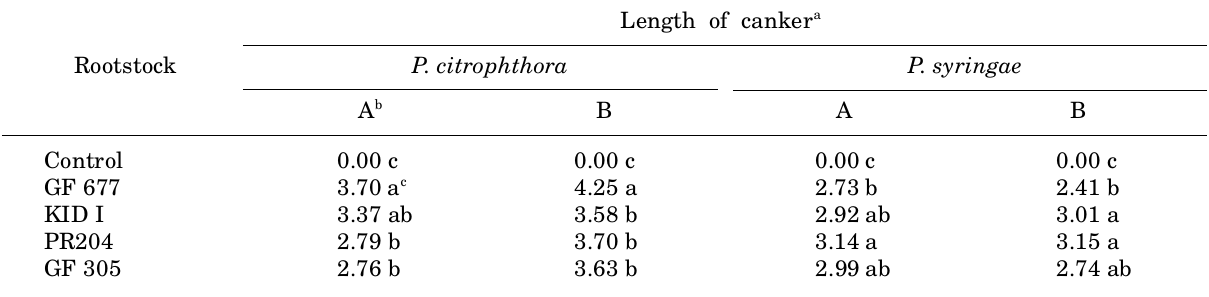
Table 3. Susceptibility to Phytophthora citrophthora and P. syringae as shown by canker length on four field grown peach rootstocks by the stem inoculation